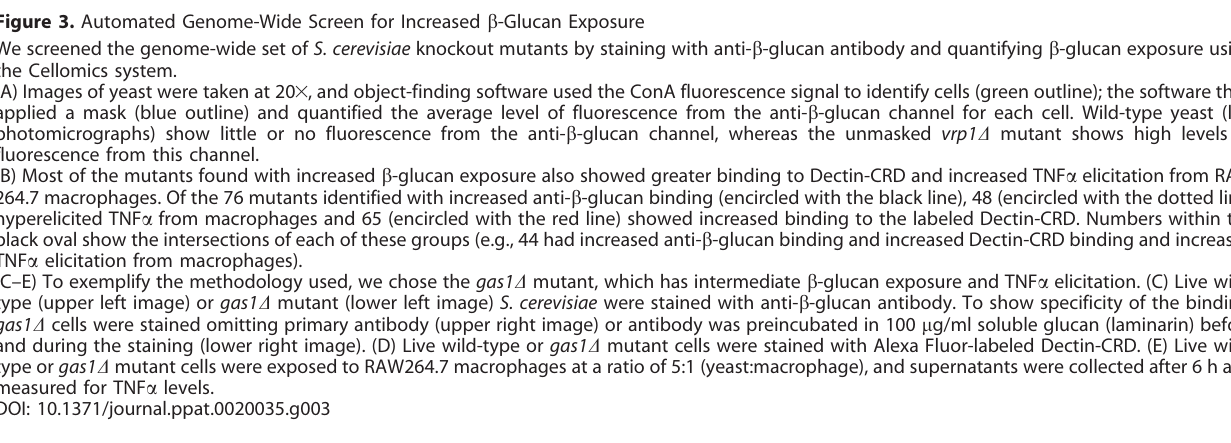
Figure 3. Automated Genome-Wide Screen for Increased b -Glucan Exposure We screened the genome-wide set of S. cerevisiae knockout mutants by staining with anti- b -glucan antibody and quantifying b -glucan exposure using the Cellomics system. (A) Images of yeast were taken at 20 3 , and object-finding software used the ConA fluorescence signal to identify cells (green outline); the software then applied a mask (blue outline) and quantified the average level of fluorescence from the anti- b -glucan channel for each cell. Wild-type yeast (left photomicrographs) show little or no fluorescence from the anti- b -glucan channel, whereas the unmasked vrp1 D mutant shows high levels of fluorescence from this channel. (B) Most of the mutants found with increased b -glucan exposure also showed greater binding to Dectin-CRD and increased TNF a elicitation from RAW 264.7 macrophages. Of the 76 mutants identified with increased anti- b -glucan binding (encircled with the black line), 48 (encircled with the dotted line) hyperelicited TNF a from macrophages and 65 (encircled with the red line) showed increased binding to the labeled Dectin-CRD. Numbers within the black oval show the intersections of each of these groups (e.g., 44 had increased anti- b -glucan binding and increased Dectin-CRD binding and increased TNF a elicitation from macrophages). (C–E) To exemplify the methodology used, we chose the gas1 D mutant, which has intermediate b -glucan exposure and TNF a elicitation. (C) Live wild- type (upper left image) or gas1 D mutant (lower left image) S. cerevisiae were stained with anti- b -glucan antibody. To show specificity of the binding, gas1 D cells were stained omitting primary antibody (upper right image) or antibody was preincubated in 100 l g/ml soluble glucan (laminarin) before and during the staining (lower right image). (D) Live wild-type or gas1 D mutant cells were stained with Alexa Fluor-labeled Dectin-CRD. (E) Live wild-